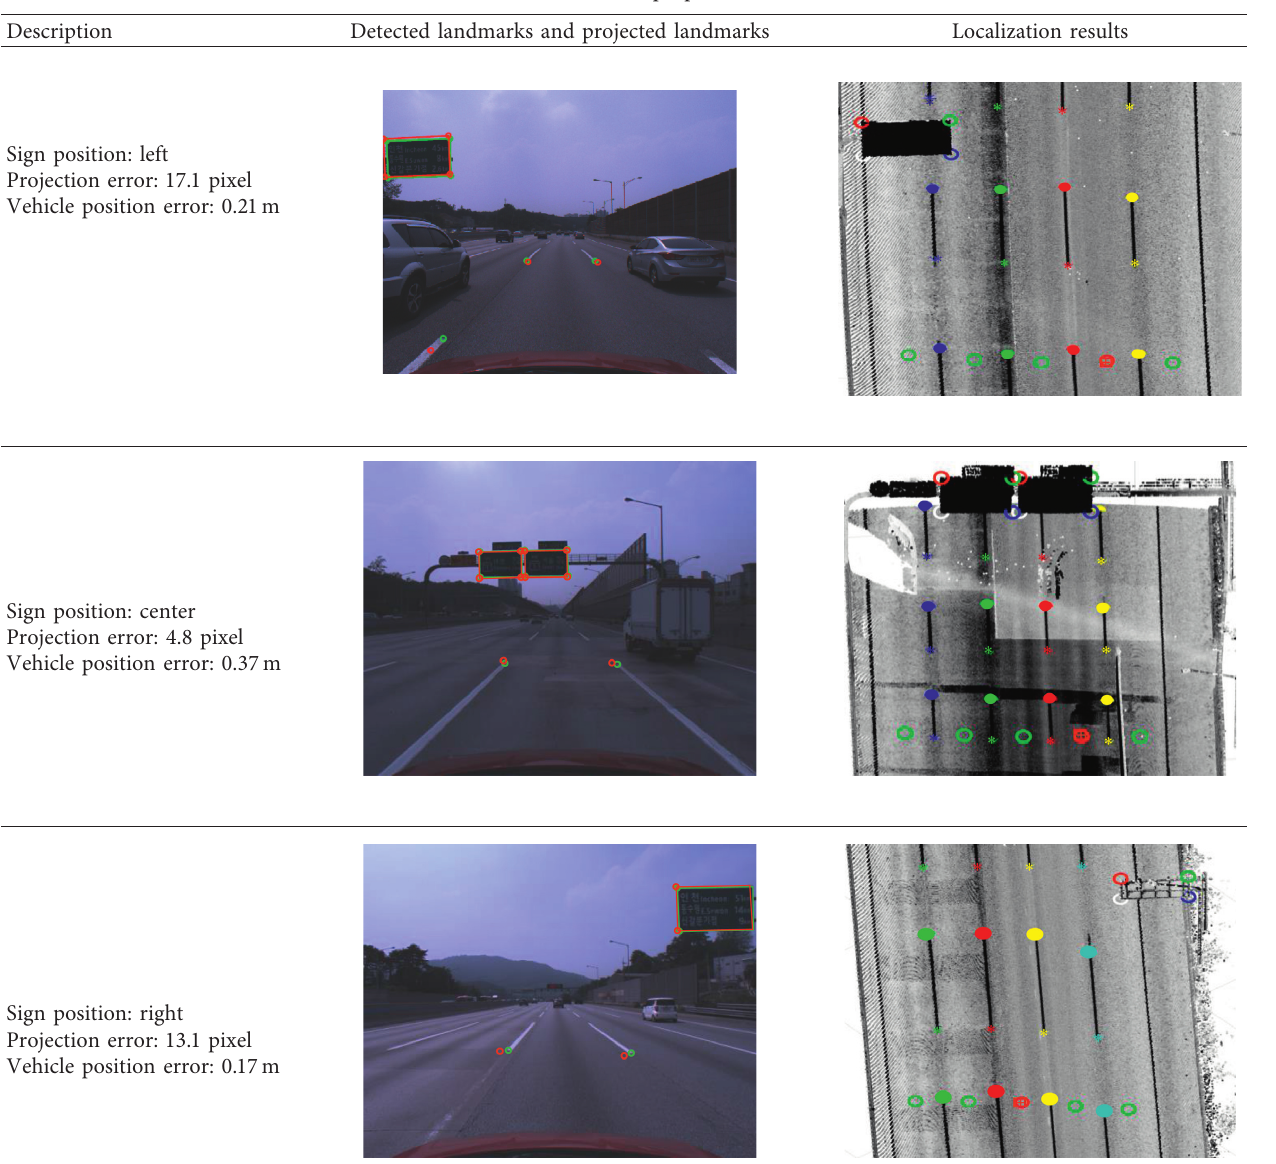
Table 6: Vehicle localization results of the proposed method in a five-lane road.